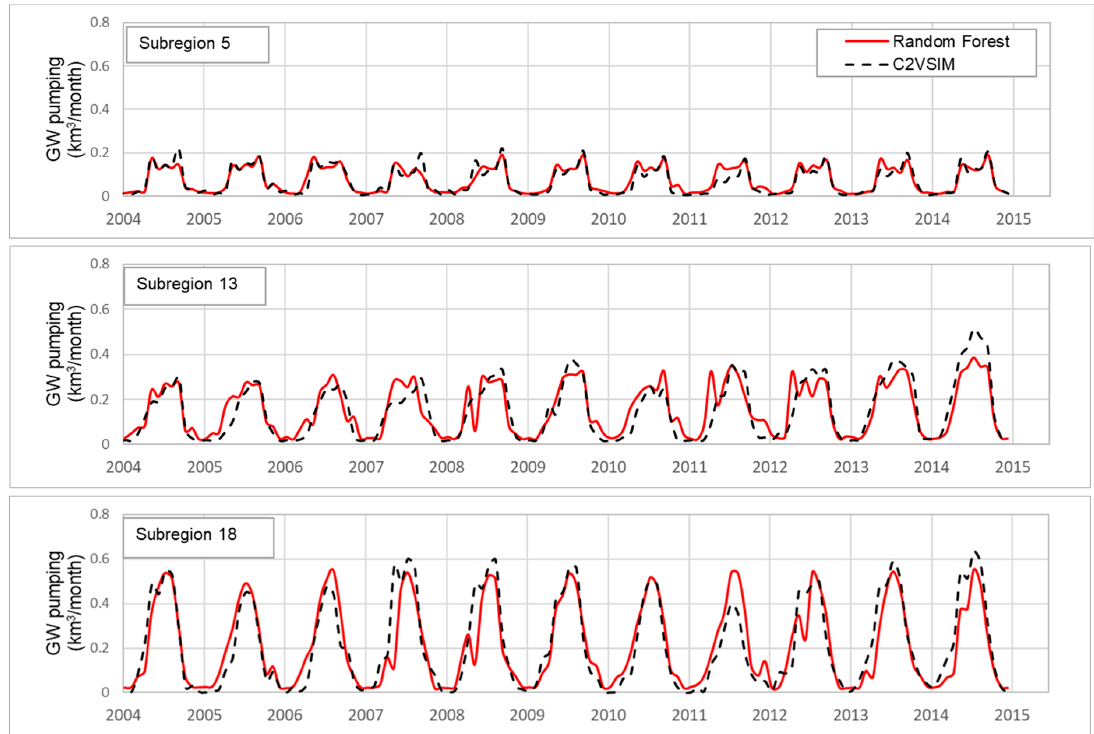
Figure 7. Groundwater abstraction comparison between random forest estimation and C2VSIM (reference) for three subregions.